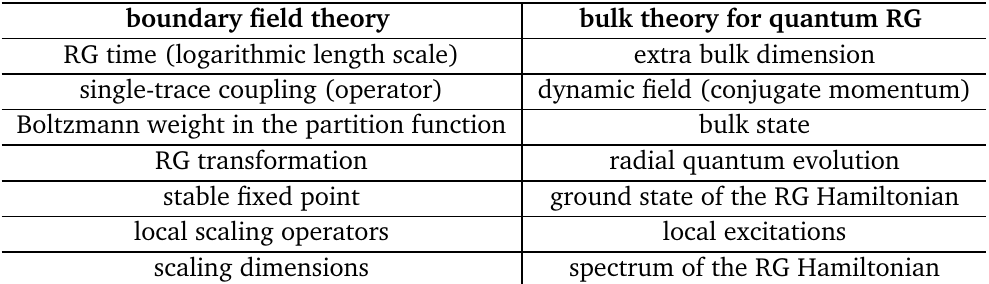
Table 1: Dictionary of correspondence between boundary field theory and bulk the-